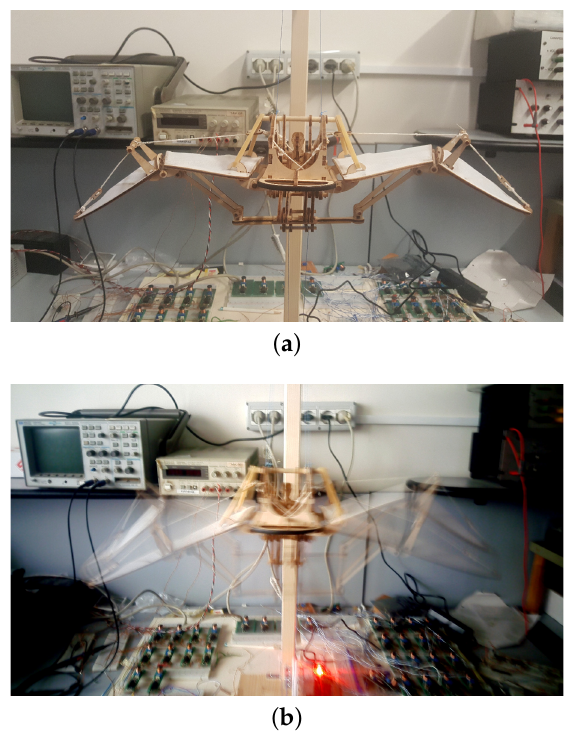
Figure 10. Flying machine stopped ( a ); flying machine in motion ( b